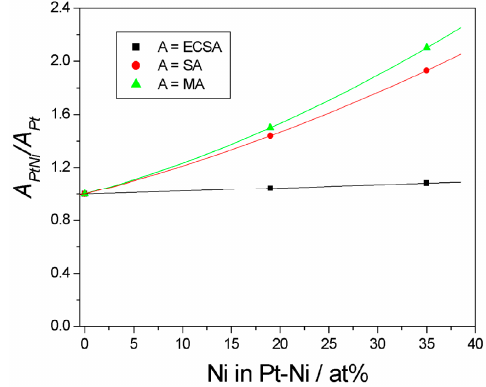
al. [42]; (X) Hu et al. [43]; (O) Zhou et al. [44].